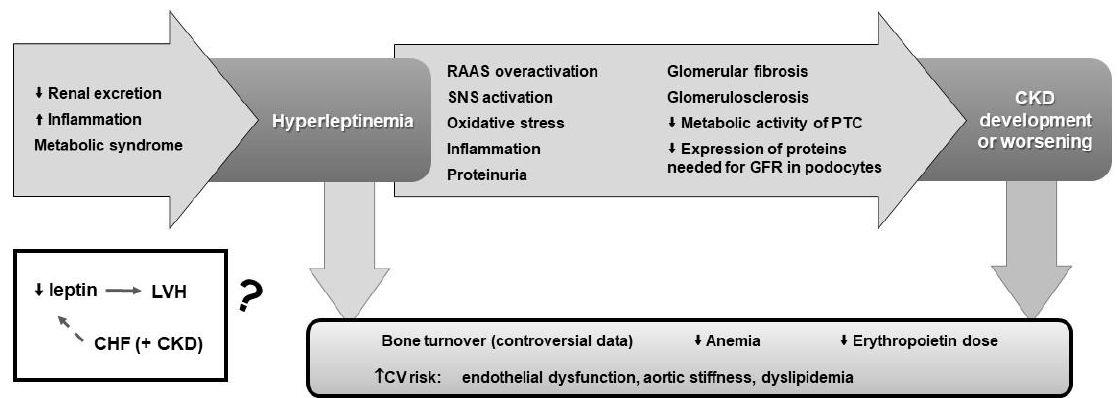
Figure 4. Schematic view of the causes that favor the increase in leptin levels in chronic kidney disease (CKD), of the negative actions of hyperleptinemia in renal function, that favors CKD development or worsening, and of its relations with common CKD comorbidities. An appointment to the surprising relation of low leptin levels and the occurrence of left ventricular hypertrophy (LVH), which may be related to the coexistence of congestive heart failure (CHF) in CKD patients, is also presented. CV, cardiovascular; GFR, glomerular filtration rate; PTC, proximal convoluted tubule cells; RAAS, renin-angiotensin-aldosterone system; SNS, sympathetic nervous system. ↑ indicates increase, ↓ indicates decrease.